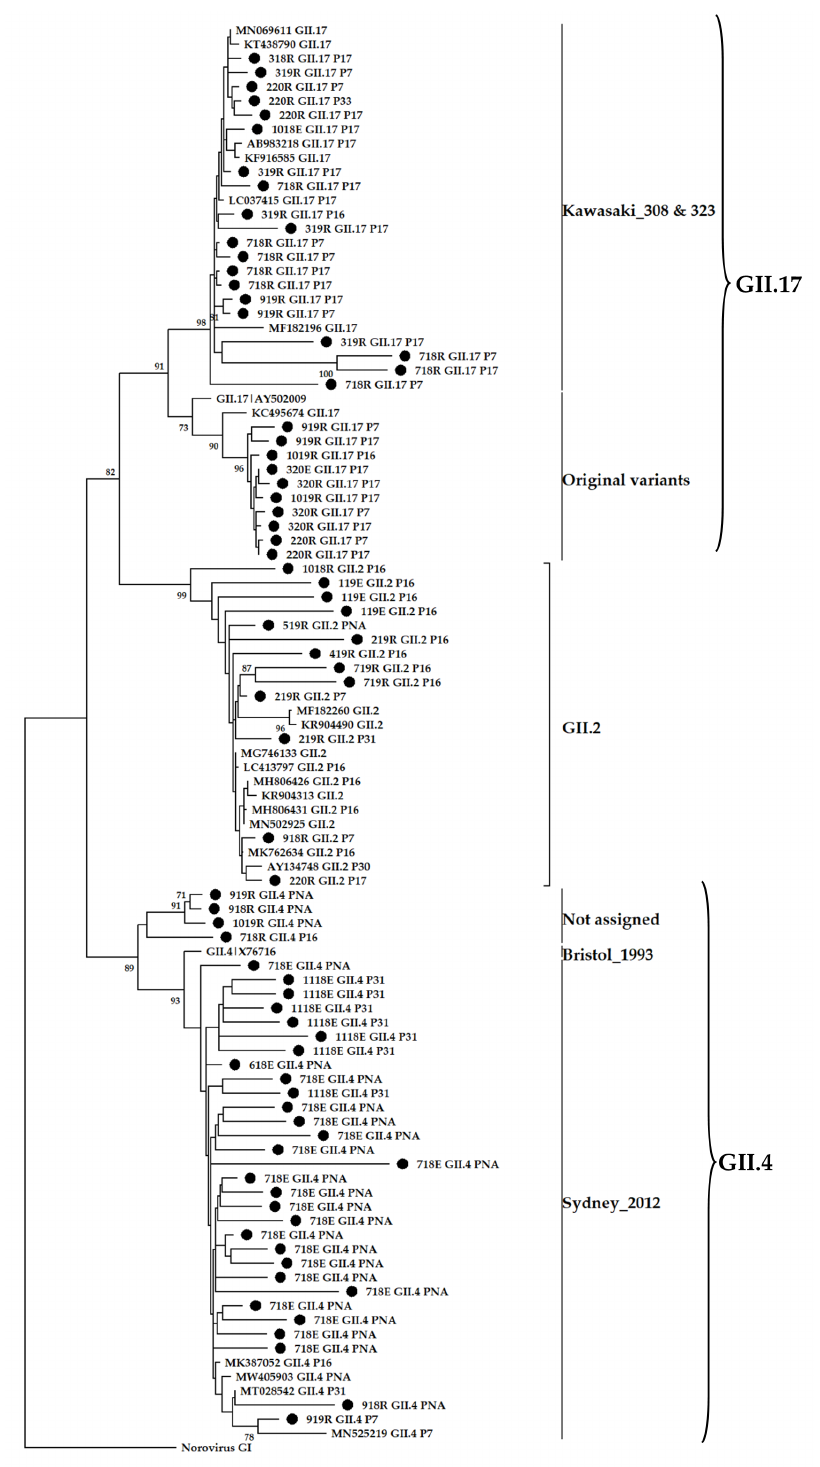
Figure 8. Phylogenetic analysis of the 302 bp at 5 (cid:48) -end of norovirus GII.2, GII.4 and GII.17 ORF2. Representative sequences identified in this study are indicated by black circles ( • ). All strain sequence names contain specific ID, genotype and P-type. Reference strains and the most closely related strains were downloaded from GenBank. The Maximum Likelihood phylogenetic tree was constructed using MEGA X software [46] and 1000 bootstrap replicates based on the Kimura 2-parameter model. The sequences were labelled according to month and year of detection, wastewater type, P-type and genotype, e.g., 1018RGII.2[P2] = GII.2[P2] virus detected in raw sewage collected in October